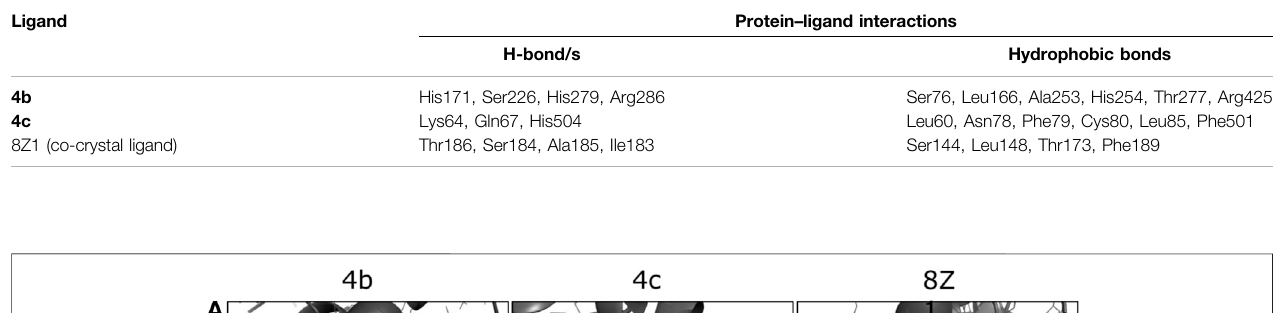
TABLE 4 | Amino acid residues of the target protein that interacts with ligands 4a and 4b .